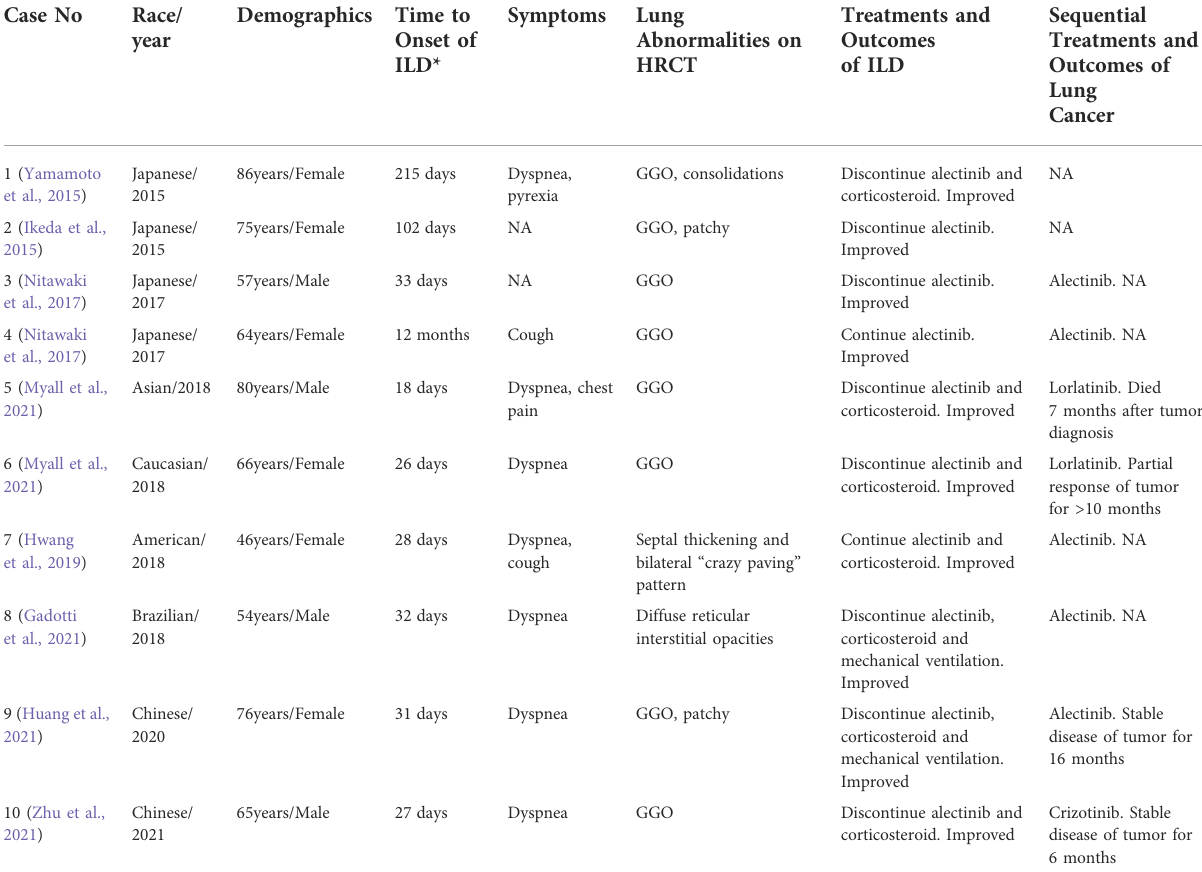
TABLE 1 Literature review of alectinib-related interstitial lung